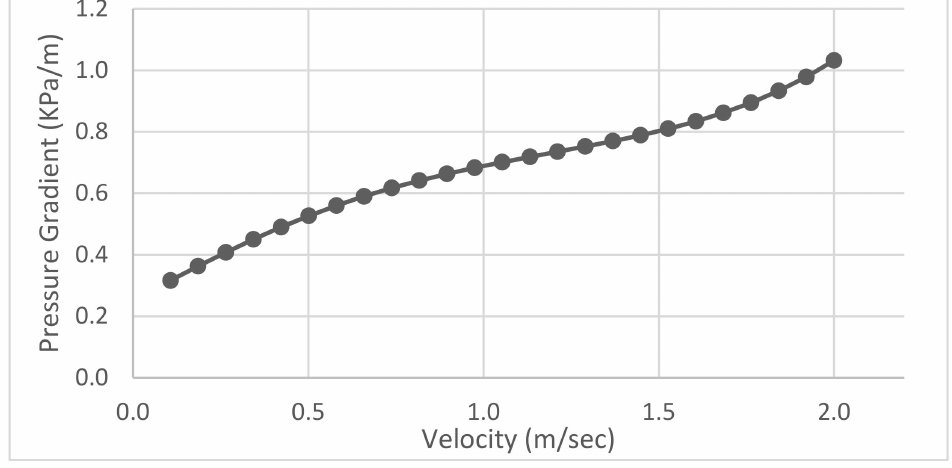
Figure 8. Effect of average velocity.